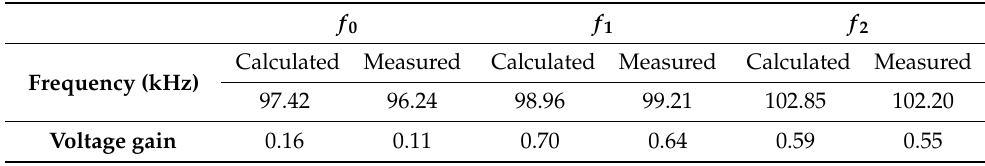
Table 3. Load-independent frequencies and corresponding voltage